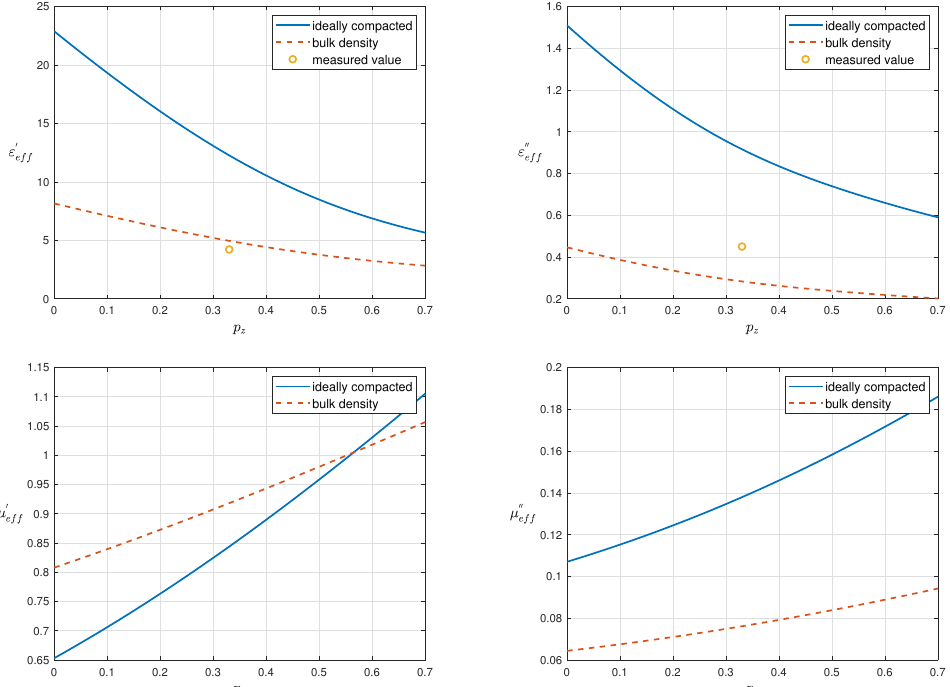
Figure 3. Real and imaginary parts of effective permittivity ε (cid:48) and µ (cid:48)(cid:48) of EAF dust powder depending on the volume fraction of the zinc-containing core–shell ef f particles p z . Solid line shows ideally compacted powder without pores; dashed line shows bulk density powder with